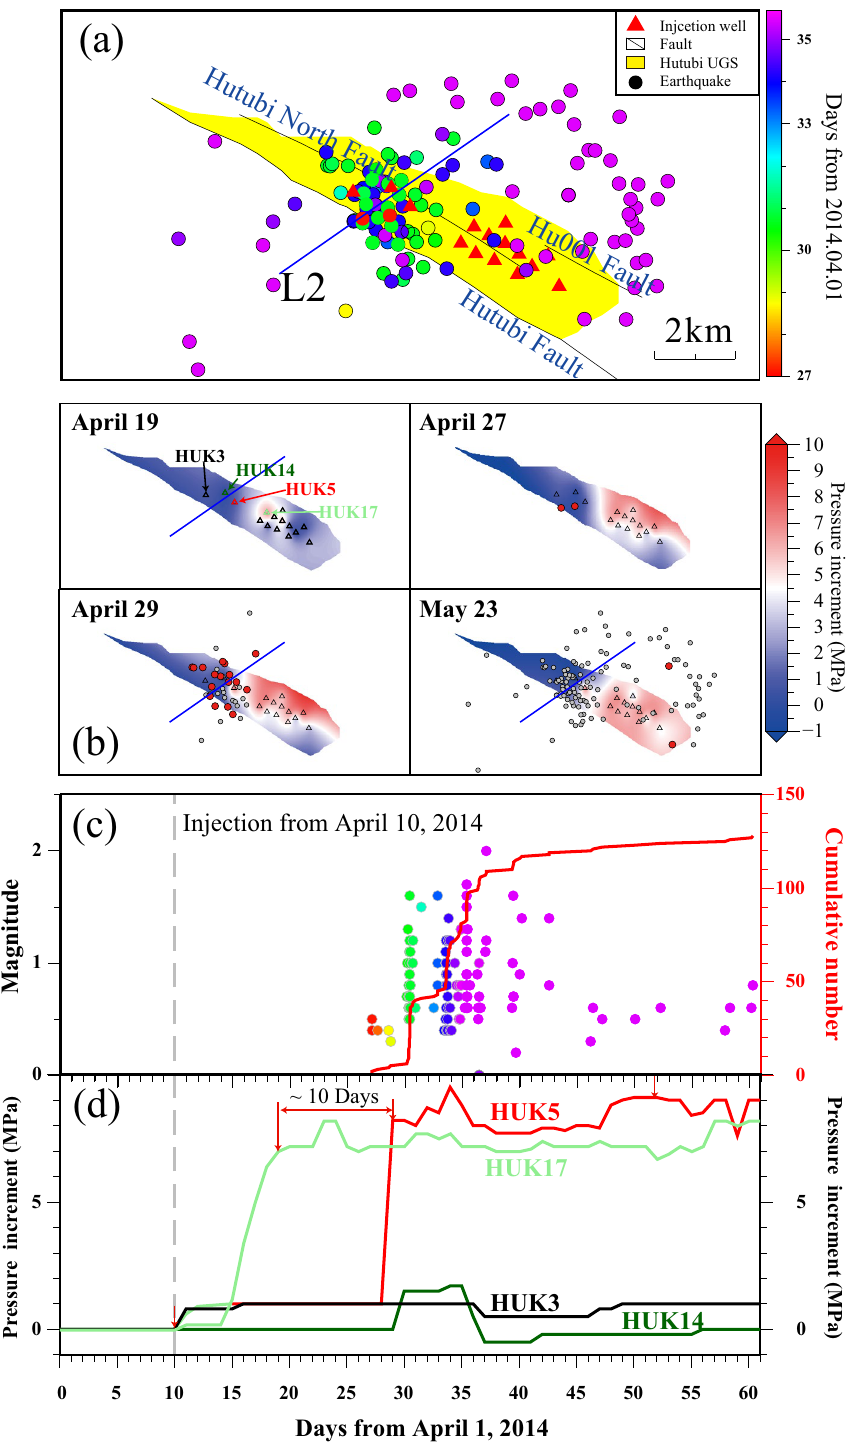
Figure 5. The map view ( a ) and M–t diagram ( c ) of the surge B seismic events occurring between April 1, 2014 and May 31, 2014. The injection wells operated during the second cycle are marked as red triangles in ( a ). The blue line L2 in ( a ) and ( b ) marks the position of profile shown in Fig. 7b and c. ( b ) The reservoir gas pressure distribution interpolated from the wellhead pressure increments relative to April 6, 2014. Current and previous earthquakes are marked as red and grey cycles, respectively. Triangles are injection wells in operation during the second injection period. ( d ) The pressure increments of the four representative wells. The gas injection started from the HUK17, and other wells began gas injection successively in the following 10 days. Three wells (HUK5, HUK3, and HUK14) were closely located in the western part of the reservoir but had prominent different well